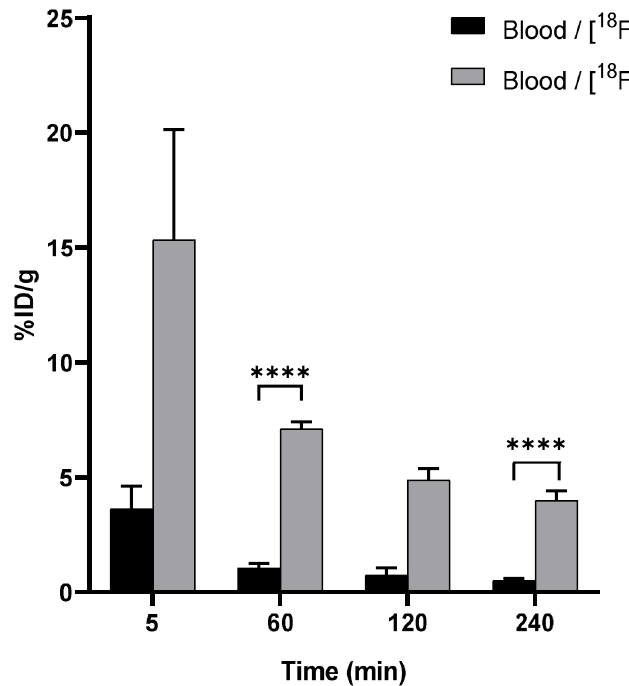
Figure 8. Radioactivity (%ID/g) in ex vivo blood samples at selected time–points, post-injection for [ 18 F]SiFA-Tz ([ 18 F] 6 ) and [ 18 F]fluoroalbumin ([ 18 F] 10 ), demonstrated a significantly prolonged circulation time for the plasma protein tracer ([ 18 F] 10 ) (**** p ≤ 0.0001).